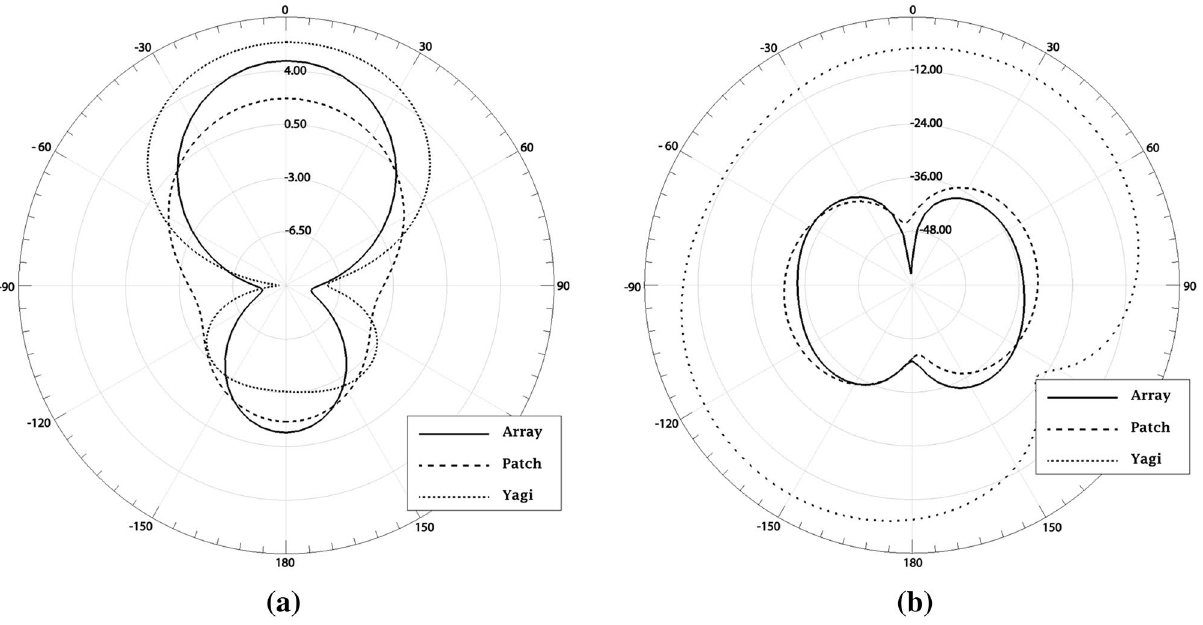
Figure 2. Radiation patterns: ( a ) co-polarization and ( b )